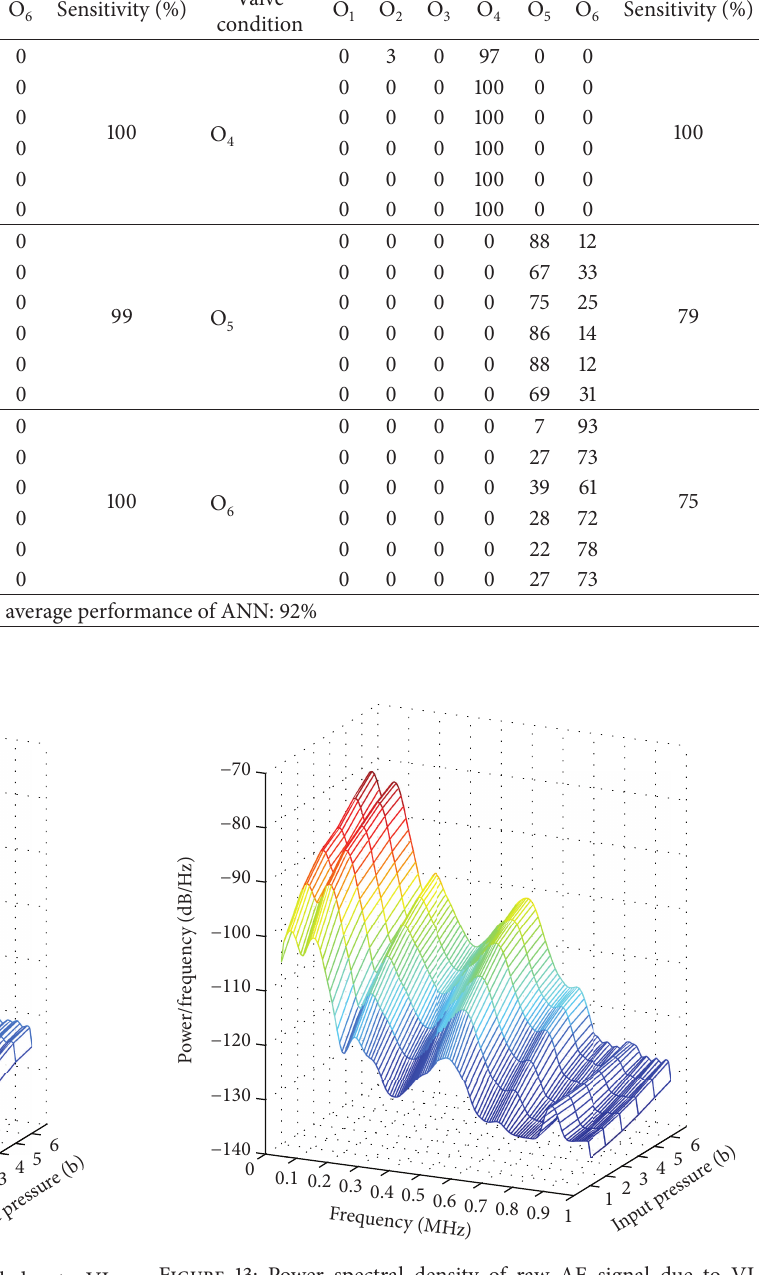
Figure 12: Power spectral density of raw AE signal due to VL through semicracked intake valve in cylinder 2.